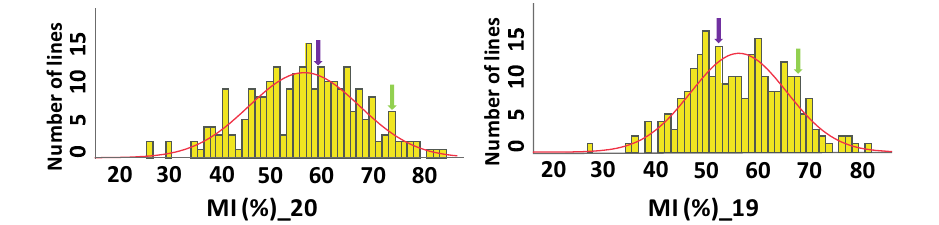
Figure 2. Phenotypic distribution of MI trait in 2019 (left panel) and 2020 (right panel). The Y-axis corresponds to the number of RIL lines in each range of MI, and X-axis corresponds to the MI value based on the average of three replicates. Arrows indicate the phenotypic values for ’IGC119’ (purple) and ’Harari’ (green). A normal distribution curve is indicated by the red